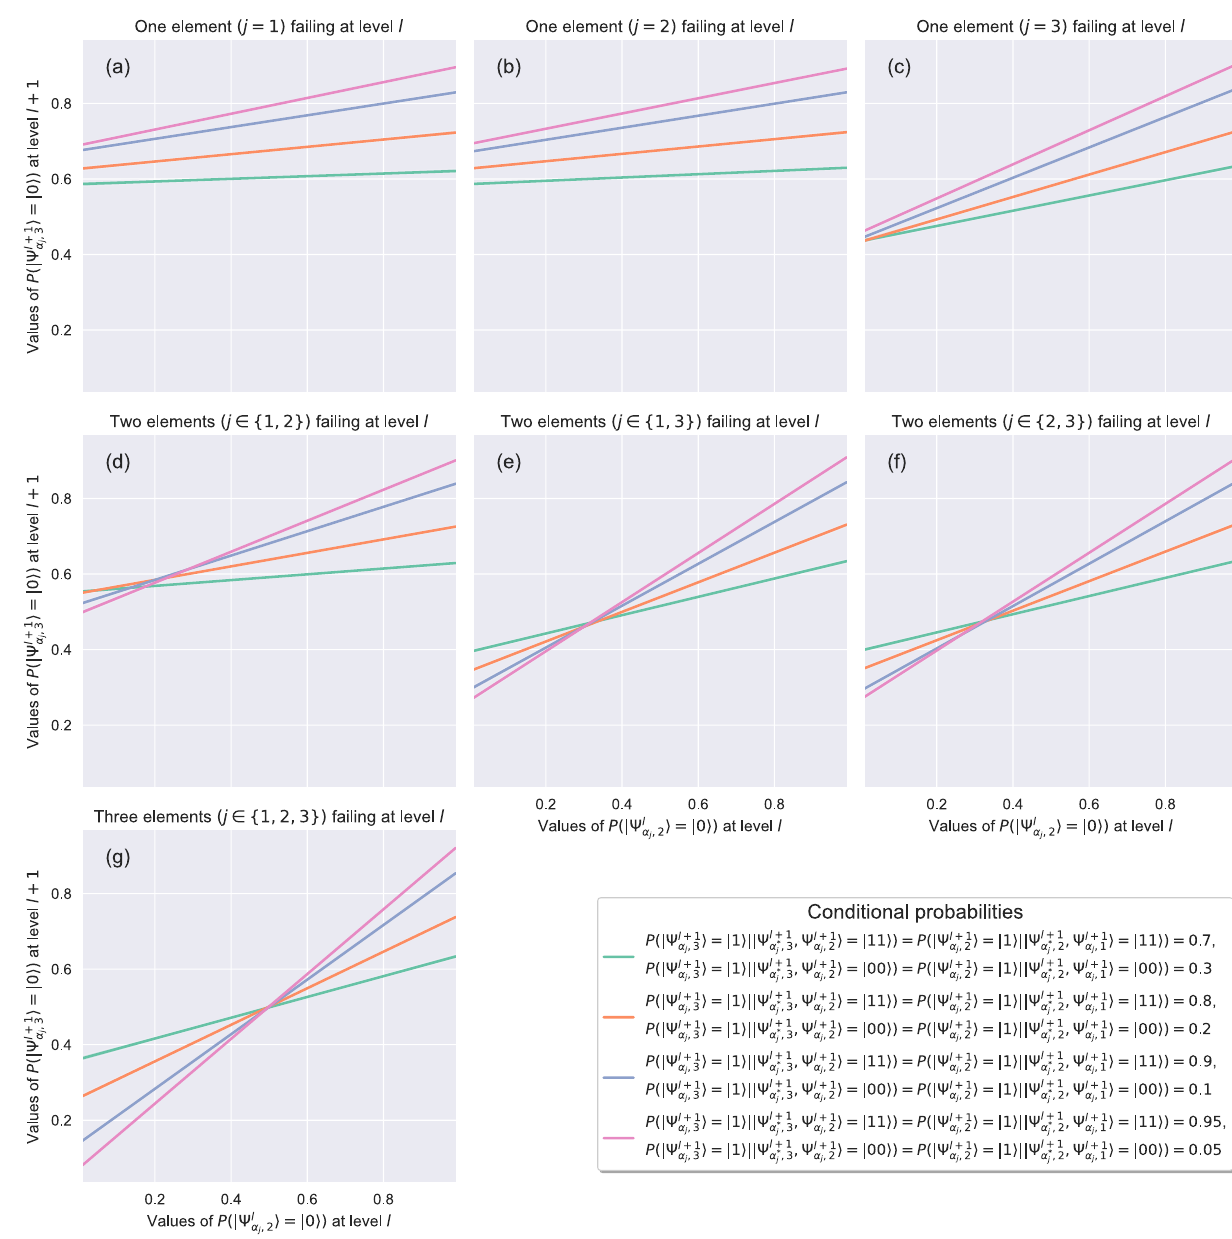
Figure 3. Performance loss of the system at level l + 1 for different failure behaviors at level l , different 1 , � l + 1 � = | 1 �|| � l + 1 � = | ab � ) , where | ab � ∈ {| 11 � , | 00 �} , combinations of P ( | � l + α j , i α j , i − 1 α ∗ j , i